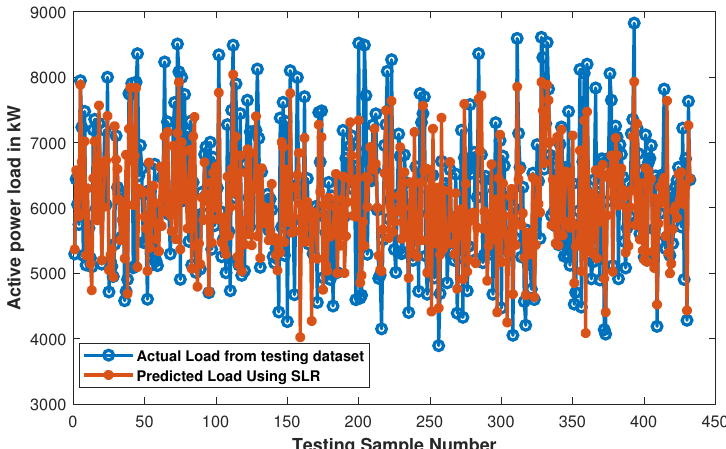
Figure 14. SLR: Comparison of actual load and predicted load with trained SLR